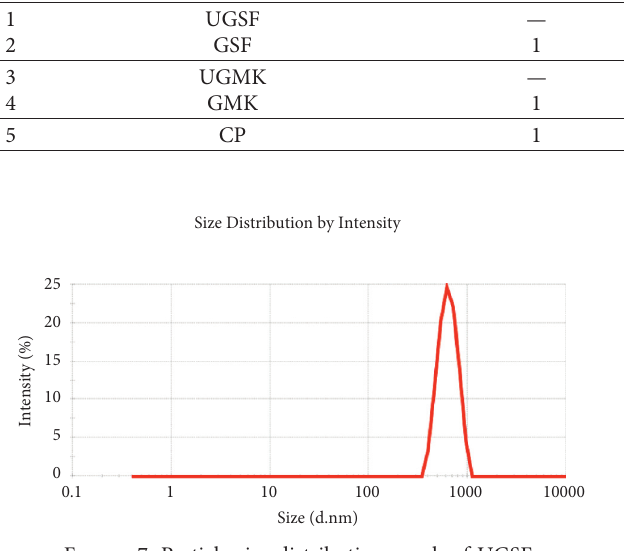
Figure 7: Particle size distribution graph of UGSF.